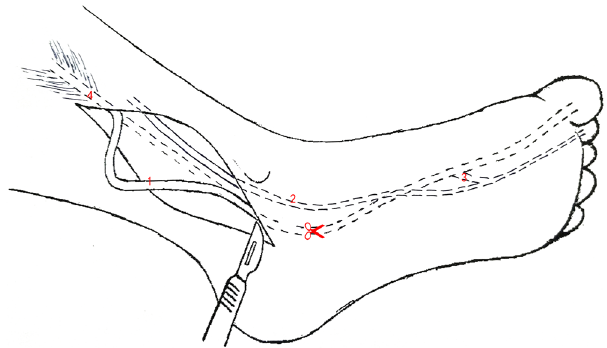
Figure 7. A single-incision technique (1). FHL tendon, (2). FDL tendon, (3). tendinous slip, (4). musculotendinous junction of FHL The red scissors indicate that the FHL tendon was cut at the level of the sustentaculum tali.